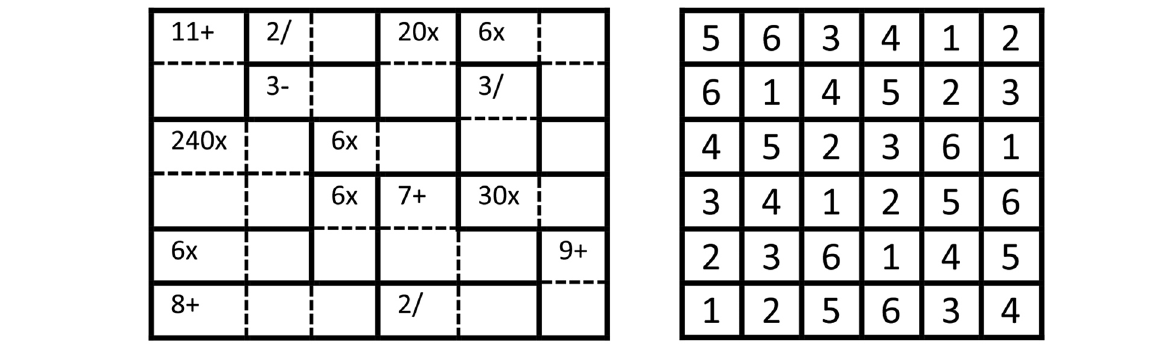
Fig. 2. A 6 by 6 KenKen puzzle layout on the left with its solution on the right